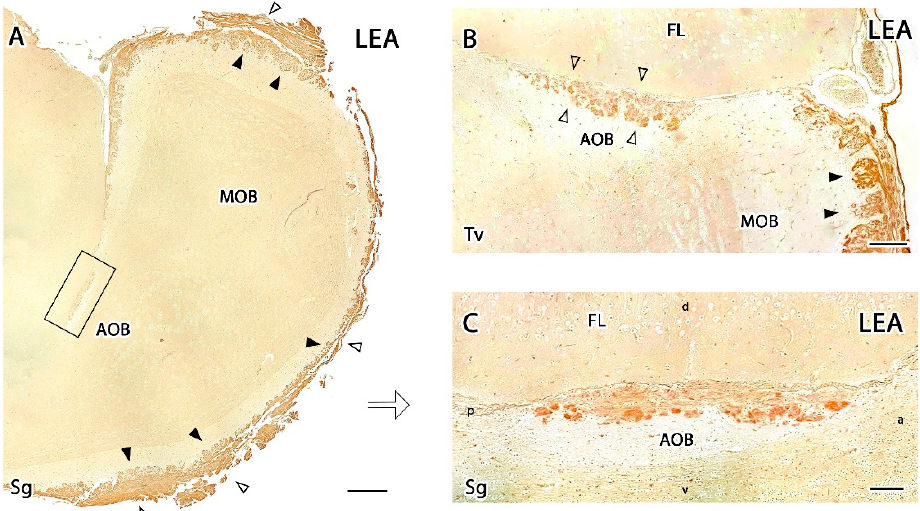
Figure 12. Histochemical study of the meerkat olfactory bulb with the lectin Lycopersicum esculentum (LEA). ( A ) Staining in the nerve (open arrowhead) and glomerular (black arrowhead) layers of the main olfactory bulb (MOB). Analogous layers of the accessory olfactory bulb (AOB) (box) show a less intense staining. ( B ) Transverse section of the olfactory bulb confirming the positive staining in the nerve and glomerular layers of both the AOB (open arrowheads), and MOB (black arrowheads). ( C ) Enlargement of the box in A showing LEA staining in the superficial layers of the AOB. Sg, sagittal plane; Tv, transverse plane. Scale bars: ( A ) 600 μ m; ( B ) 100 μ m; ( C ) 50 μ m.